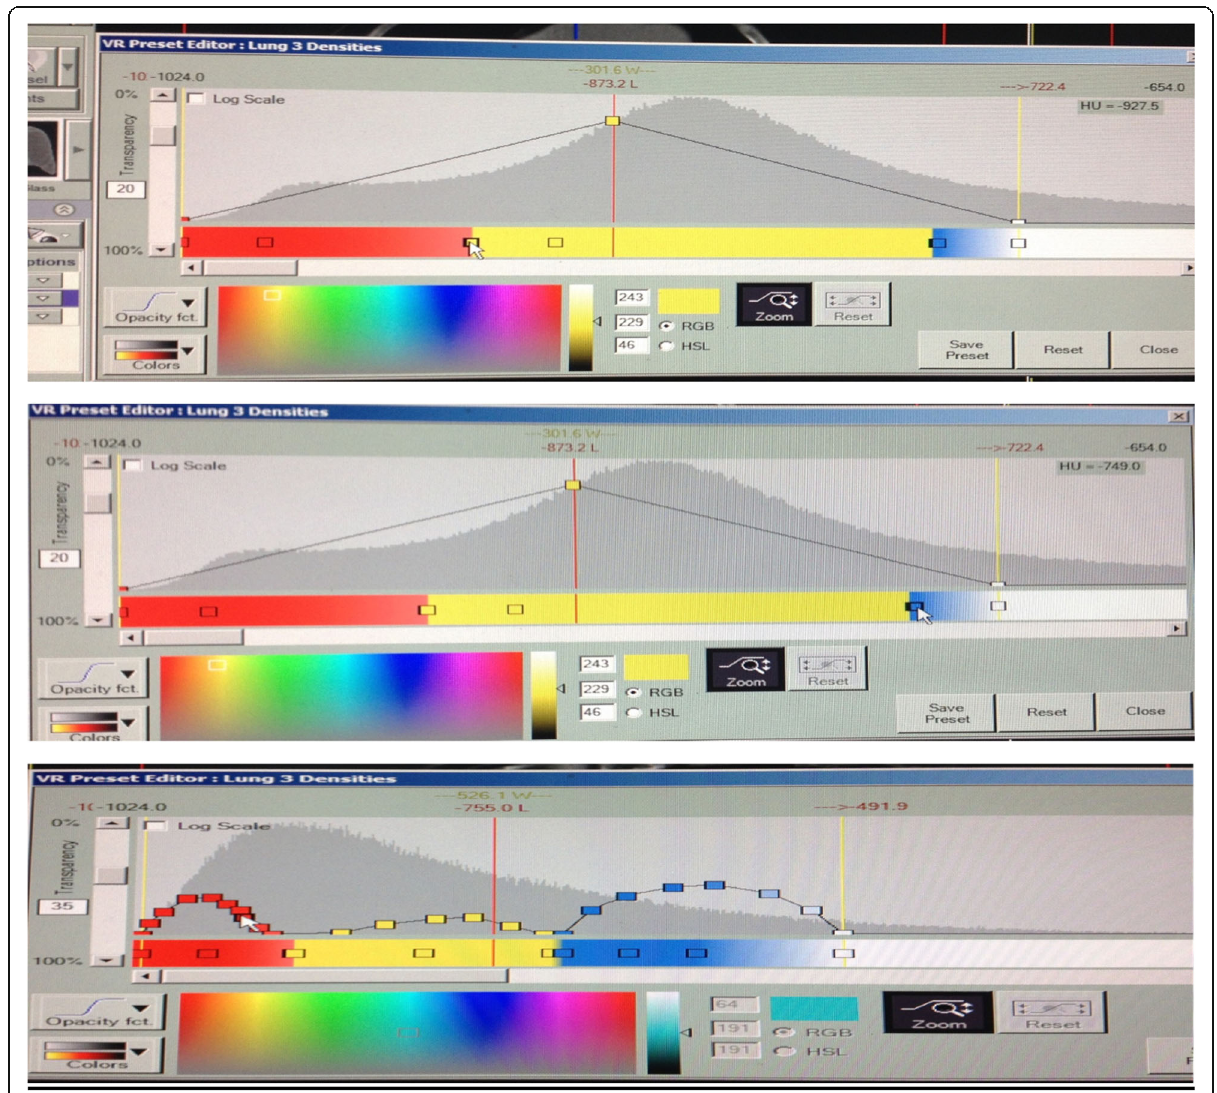
Fig. 2 Lung 3D volume rendering preset curve